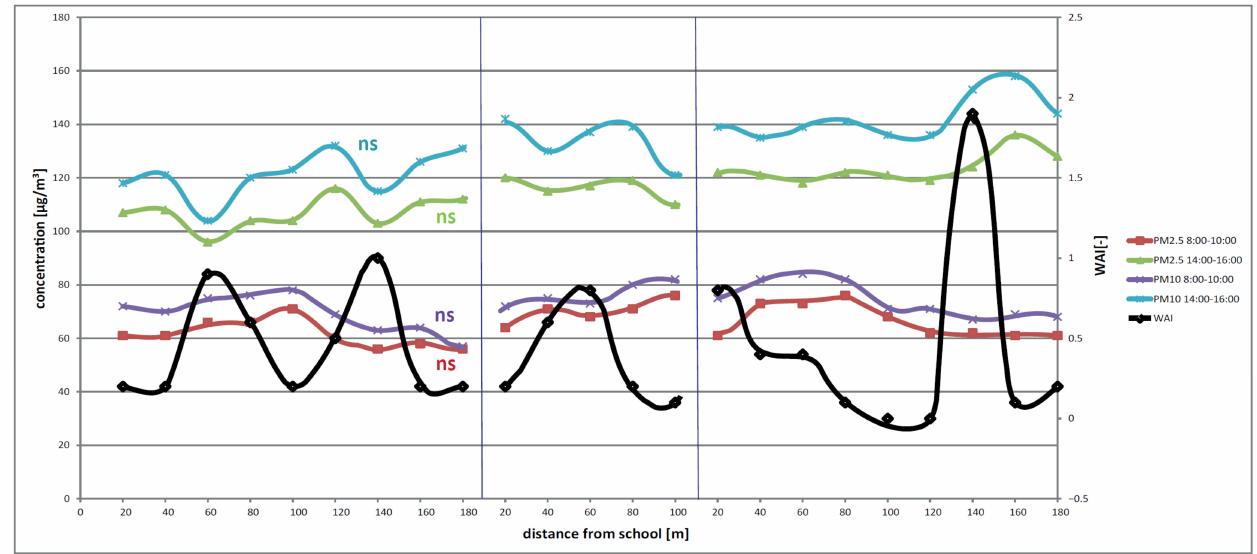
Figure 5. WAI distribution and an average PM concentration from 8:00 to 10:00 and from 14:00 to 16:00 in study plots along walking paths to school B (high share of trees, high number of local heating emission sources). ns—no